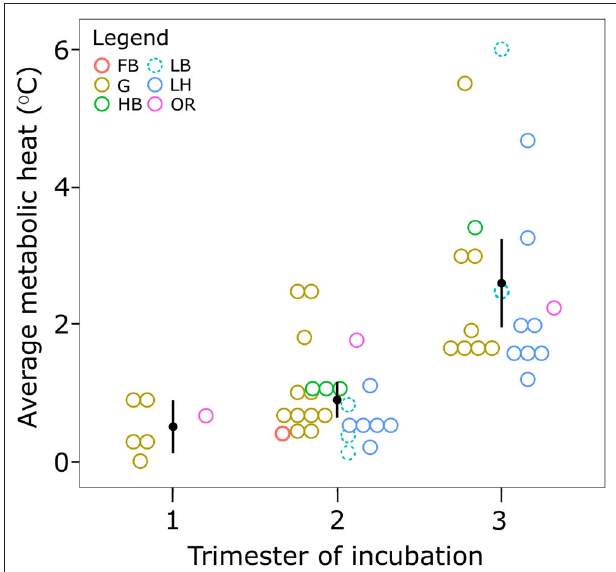
FIGURE 2 | Average metabolic heat recorded in the nests of sea turtles in each trimester of development. Only studies that measured metabolic heat by comparing the temperature in the center of a clutch to that of the surrounding sand are included. Metabolic heat is reported as the difference in these two values. Symbols represent species where FB, flatback; G, green; HB, hawksbill; LB, leatherback; LH, loggerhead; OR, olive